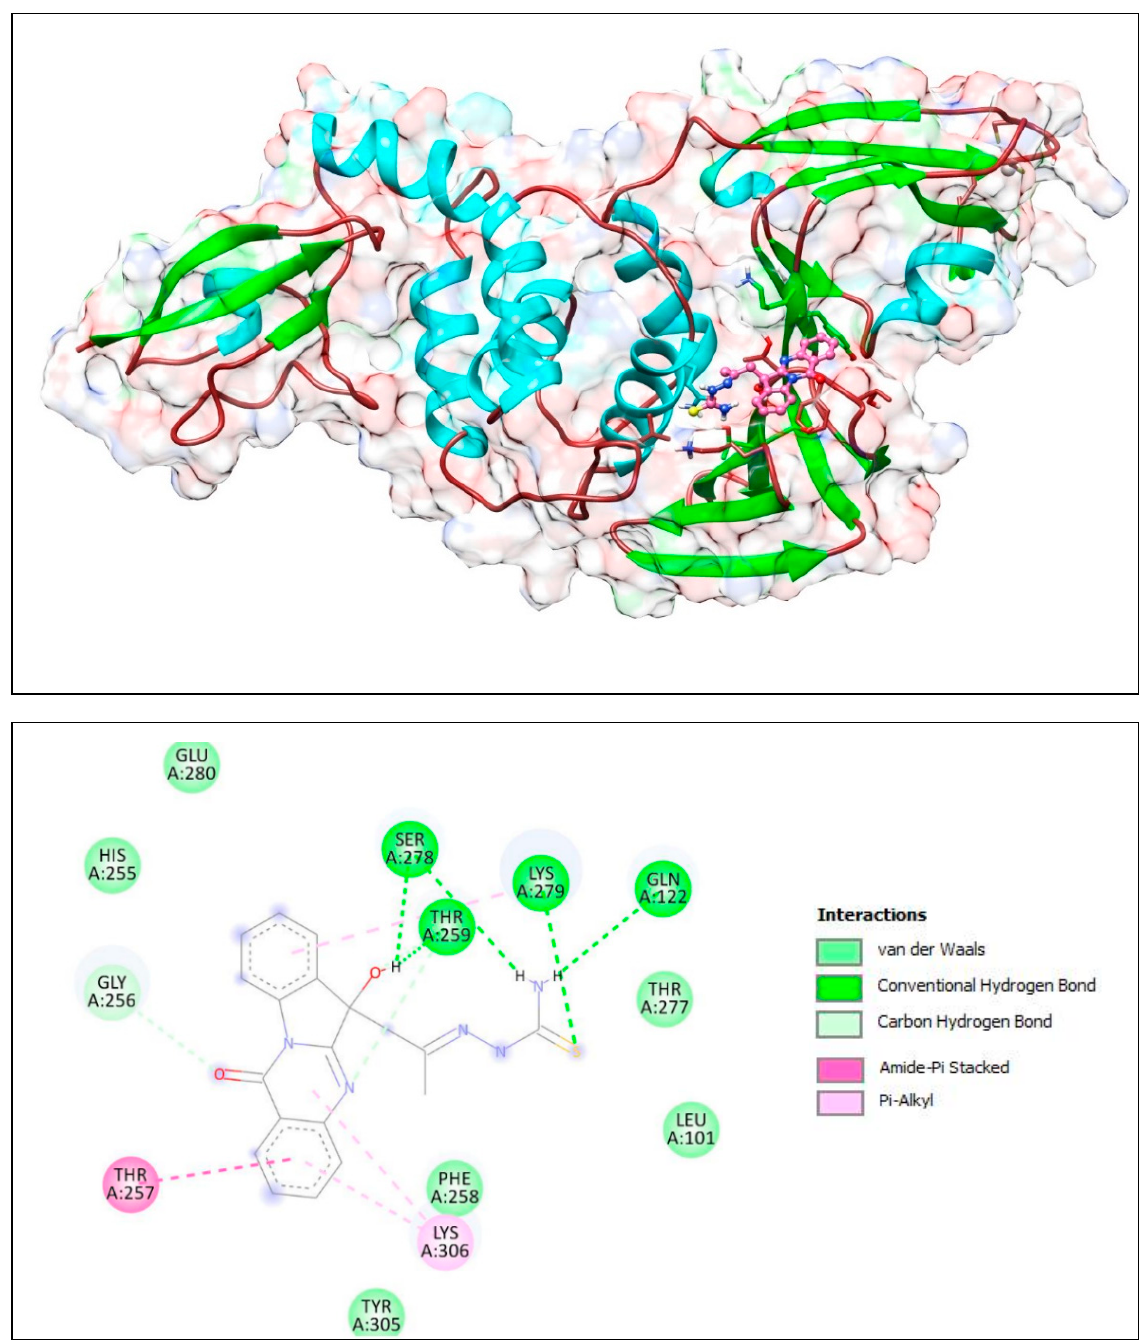
Figure 8. Complex of PLpro with PAA-TSC. The upper panel shows a 3D model of PLpro with a binding site (cavity) on its surface for the PAA-TSC compound. The lower panel shows the interaction of PAA-TSC with the amino acid residues of PLpro. Figure 8 was created with UCSF Chimera ( upper panel ) and BIOVIA Discovery Studio Visualiser ( lower panel ) and shows the best docking pose of compound PAA-TSC on the PLpro protease. We can also see where the PAA-TSC is placed on the PLpro surface and a general view of the complex of PLpro (green–cyan–brown) with PAA-TSC (pink). The secondary structure of the protease behind the molecular surface (created with 90% transparency for better presentation of the molecule) is also shown.